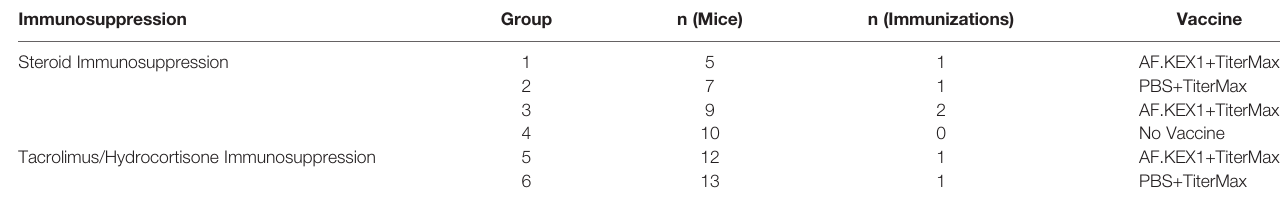
TABLE 1 | Vaccine